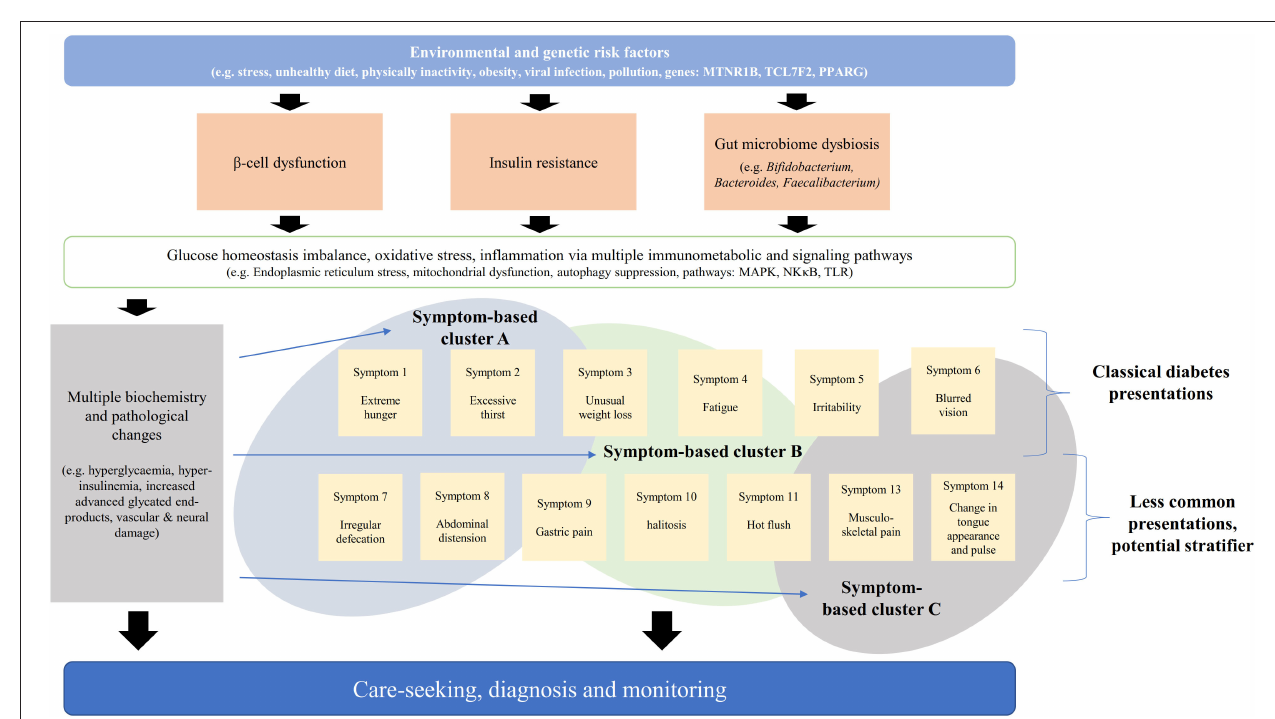
clusters. Explanatory power and complexity of statistical